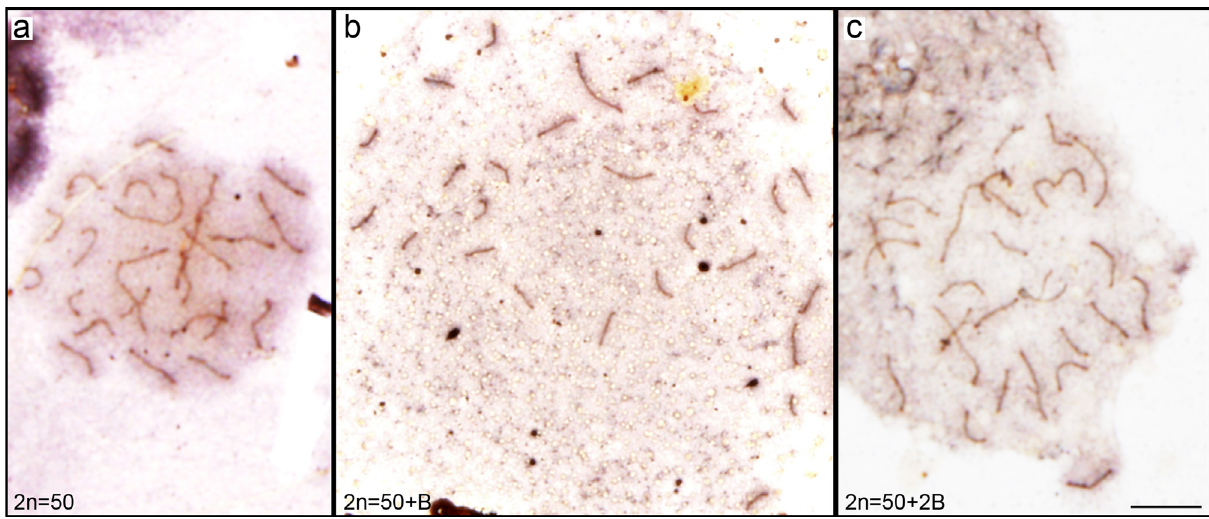
Figure 2 – Detection of P. paranae synaptonemal complexes by silver nitrate staining (A, B, C). Diploid numbers of individuals are indicated in the lower left corner. Bar = 10 µm.